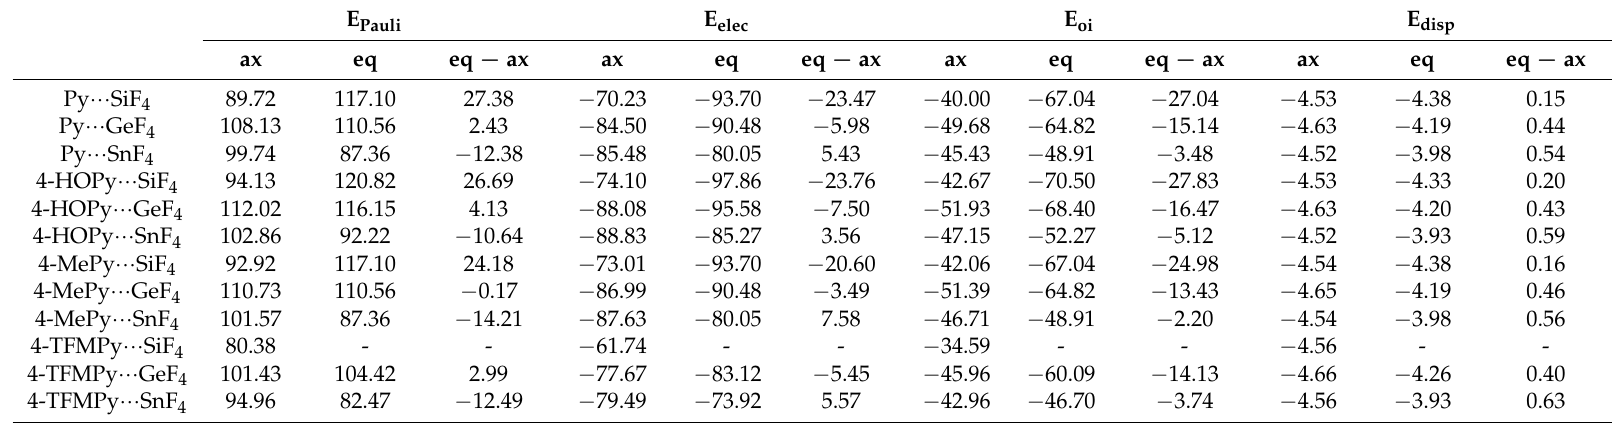
Table 7. EDA/BLYP-D3/ZORA/TZ2P decomposition of the interaction energy of complexes into Pauli repulsion (E Pauli ), electrostatic (E elec ), orbital interaction (E oi ) and dispersion (E disp ) components. All energies in